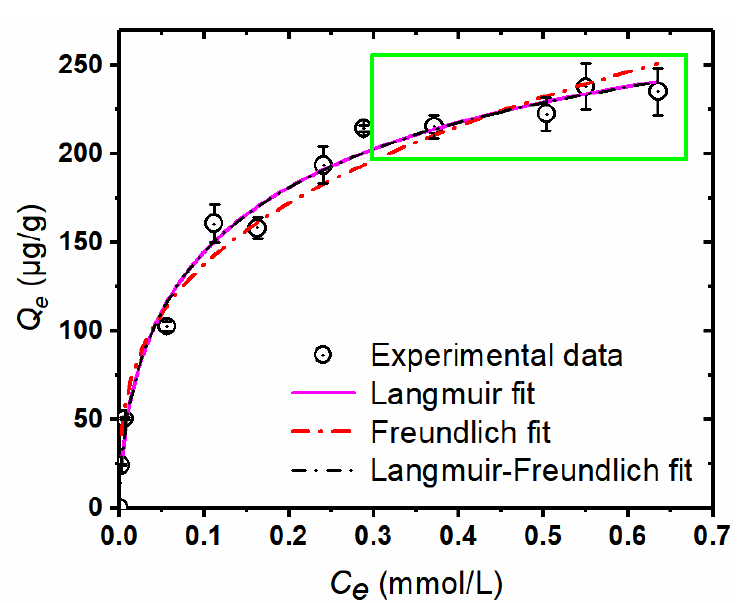
Figure 4. Adsorption isotherms of MTAs V on 0.50 g/50 mL sediments at pH 7 and 25 °C. The data in the green rectangle represent a stable trend of MTAs V sorption ( Q e ) at higher As equilibrium concentrations ( C e ).